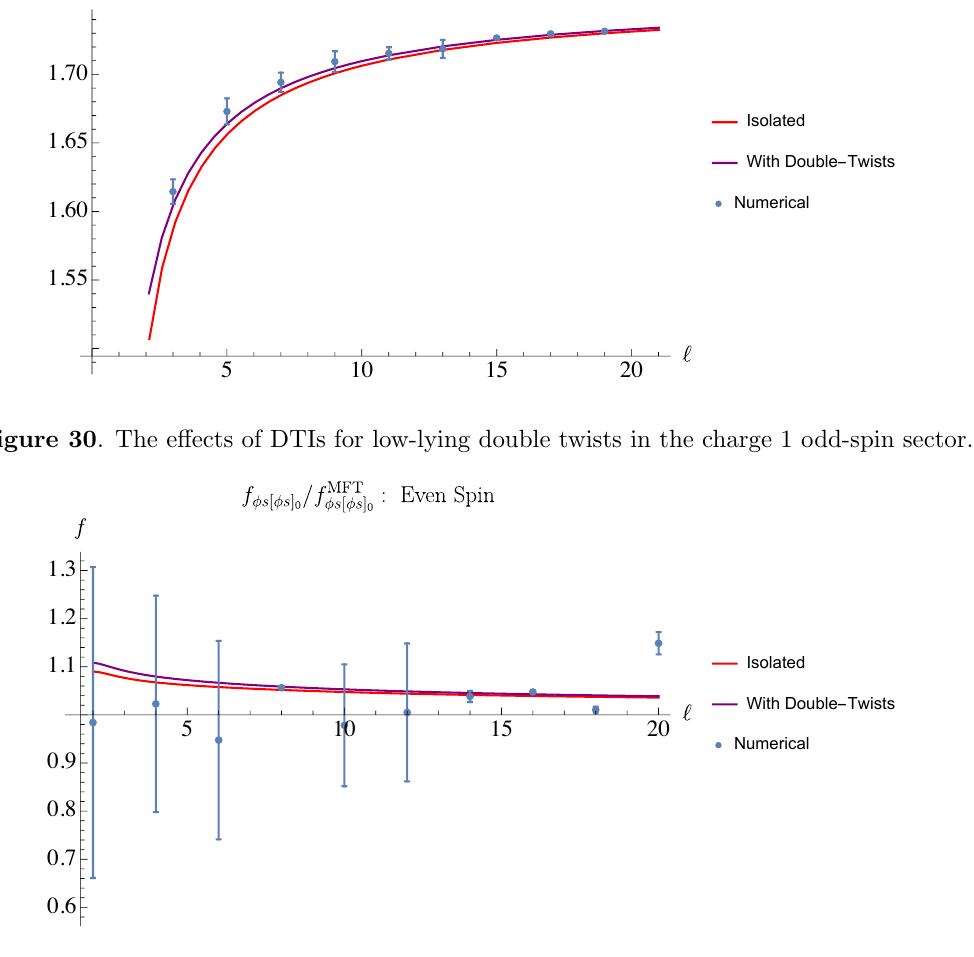
Figure 31 . The e(cid:11)ects of DTIs for OPEs of di(cid:11)erent low-lying double twists in the charge 1 [ (cid:30)s ] 1 even-spin